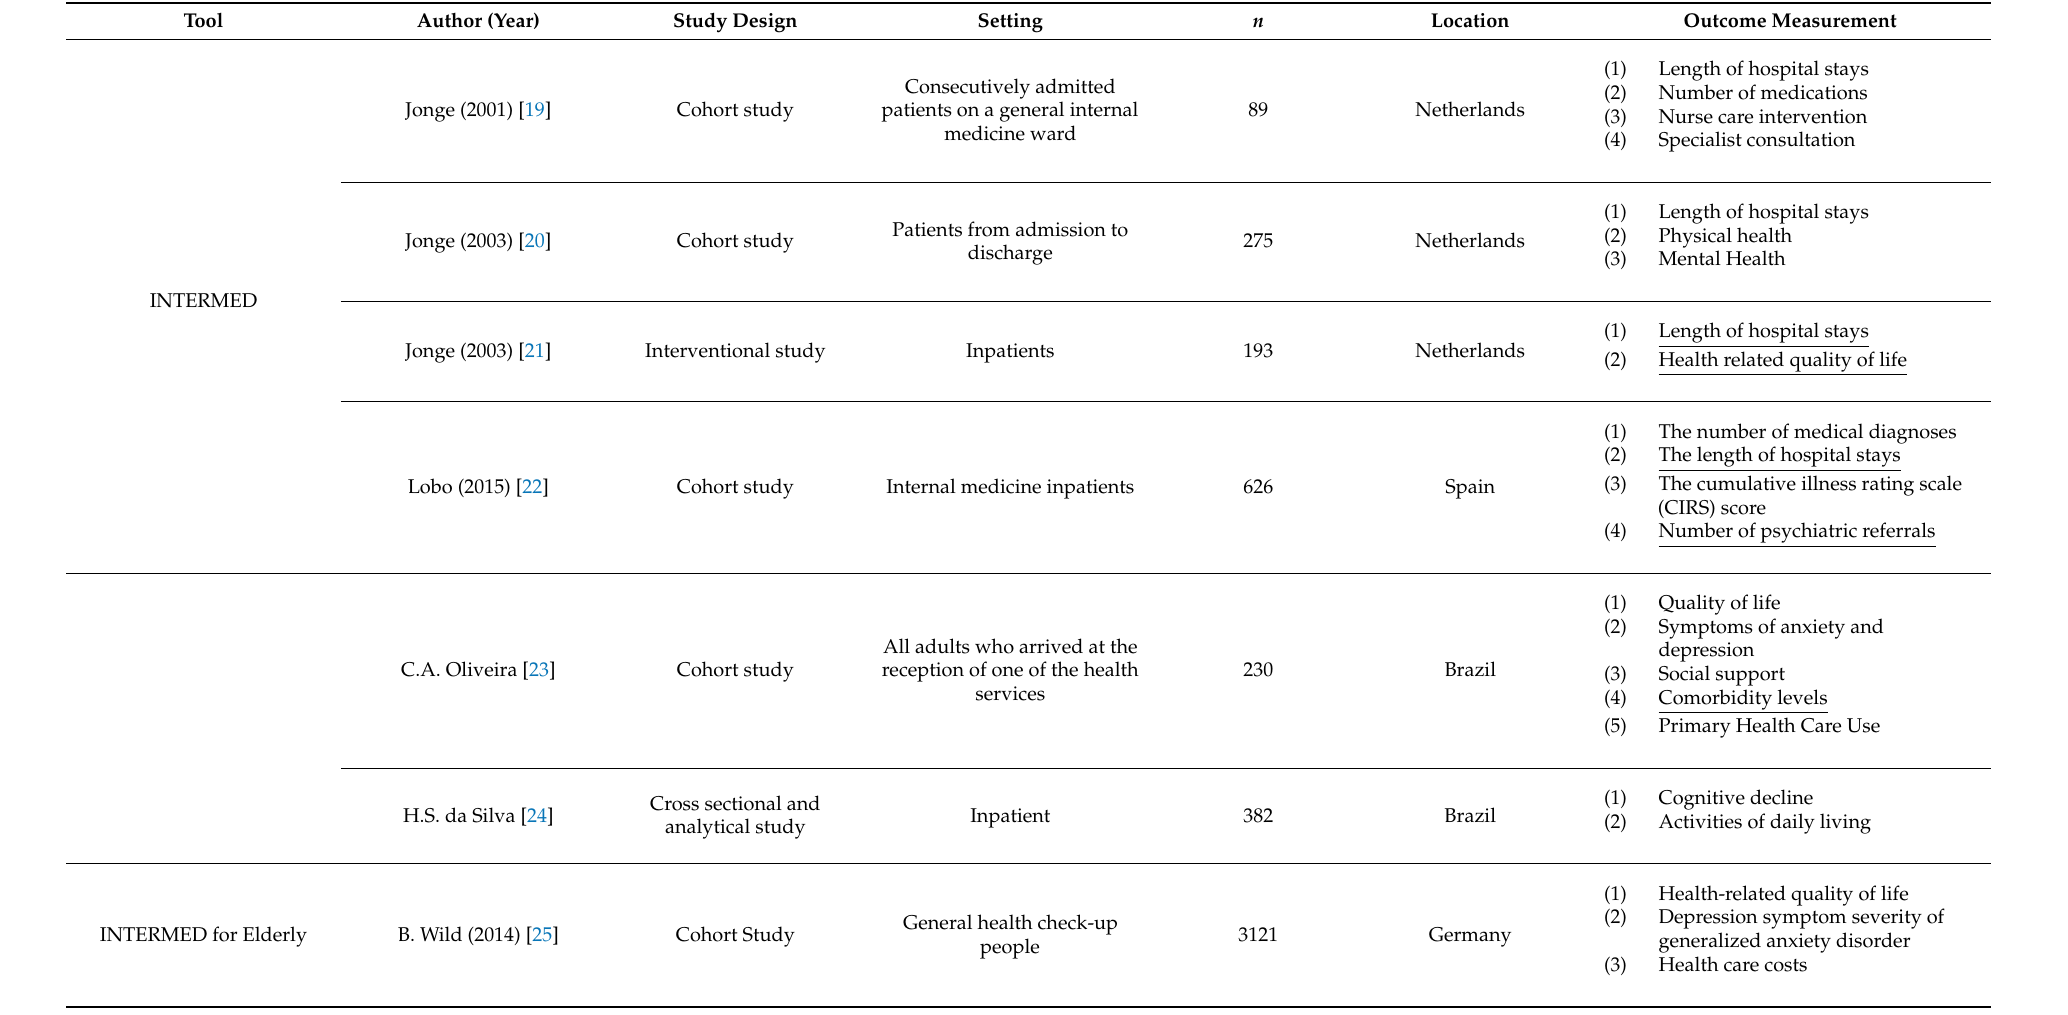
Table 1. Characteristics of included